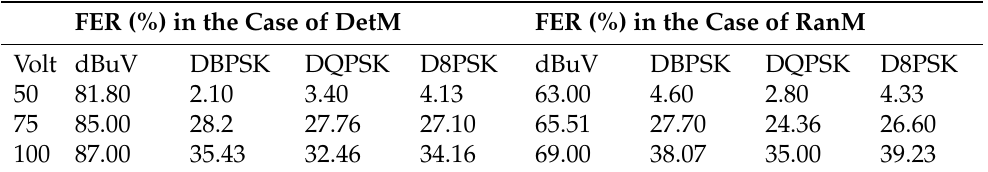
Table 4. The probability of data transmission error in the PLC with the increase in supply voltage.